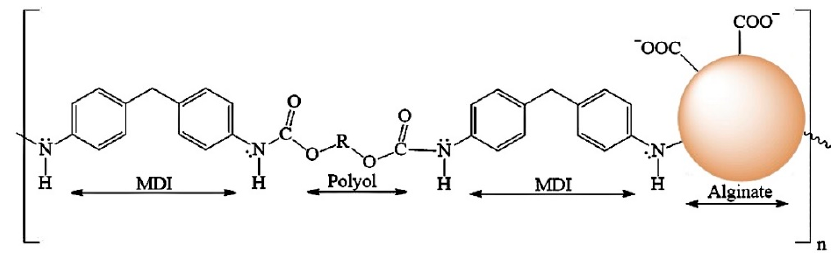
Figure 1. The estimated ALG-PUC